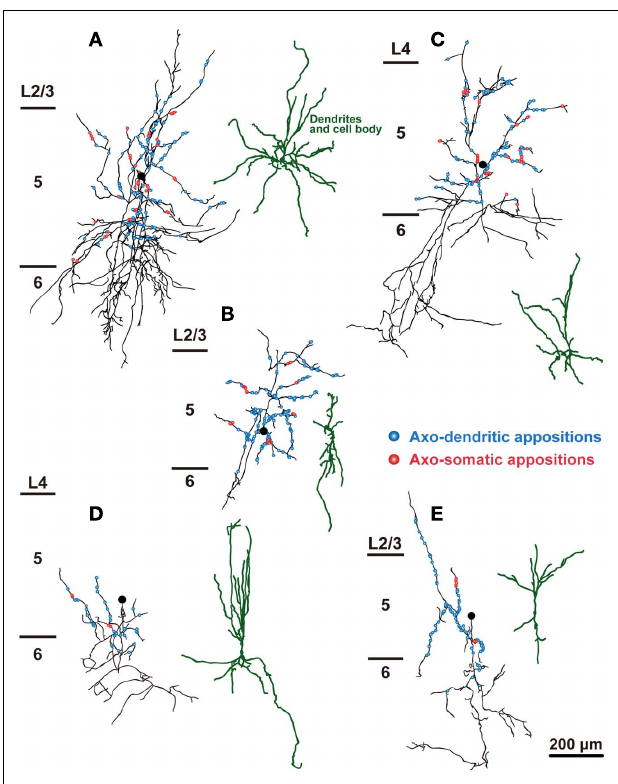
FIGURE 6 |The distribution of axon boutons of non-FS/non-SOM neurons in close appositions to CSNs. Axons and dendrites of L5 non-FS/non-SOM neurons were reconstructed and projected to the frontal plane. Black lines and filled circles indicate the axons and cell bodies of non-FS/non-SOM neurons, respectively. Blue and red circles indicate the axodendritic and axosomatic appositions, respectively.The dendrites were reconstructed dark green. Note that the appositions were much fewer than FS or SOM neurons. Scale bar in (E) applies to (A–E) .